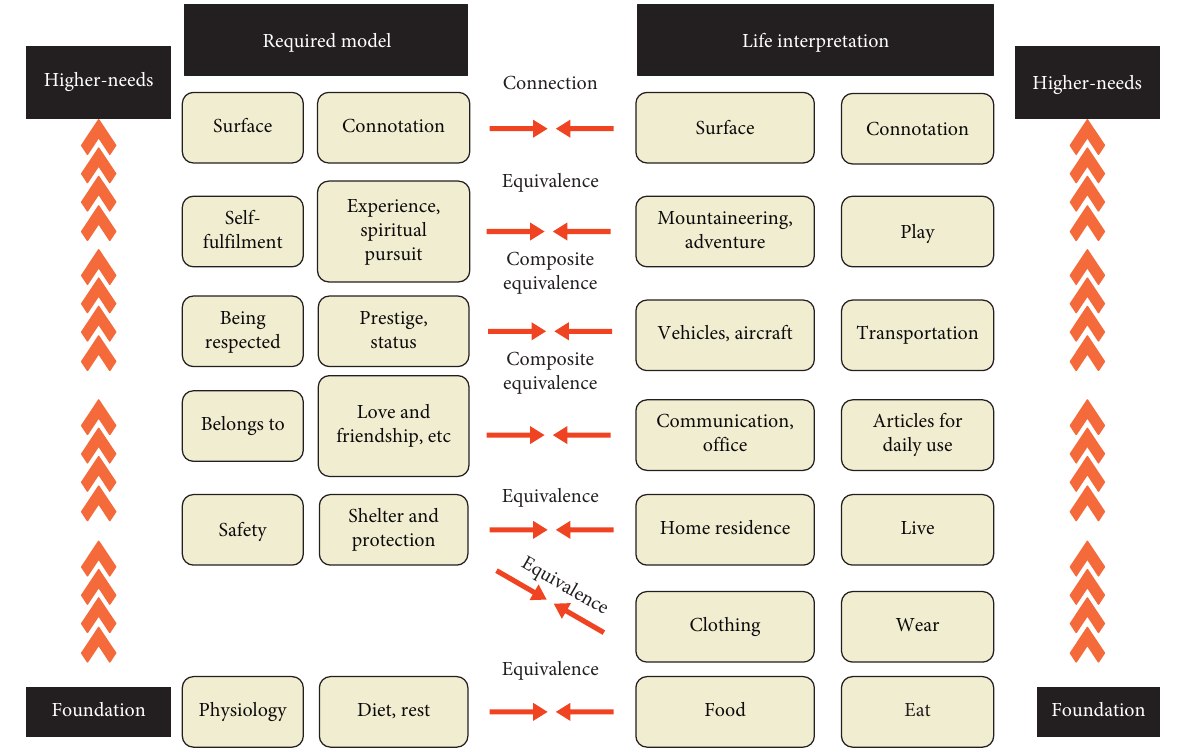
Figure 6: The relationship between life needs and needs models in the traditional